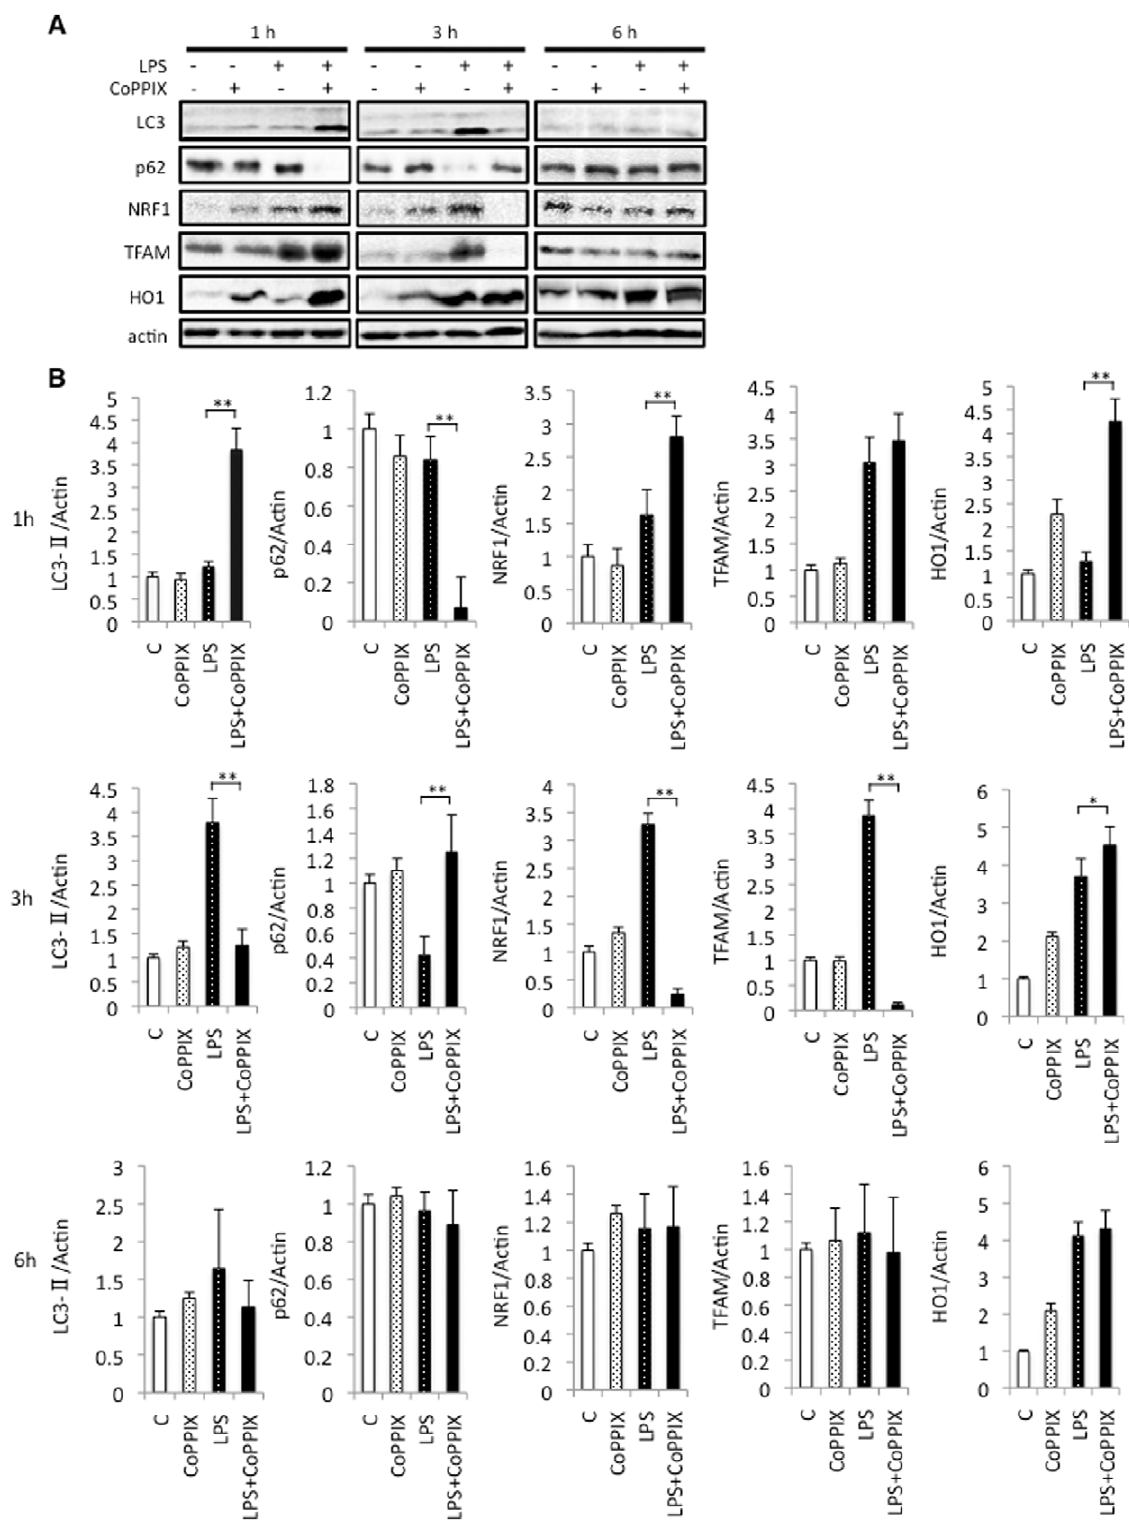
Figure 3. Effects of CoPPIX on autophagy and mitochondrial biogenesis during LPS treatment in the heart. A, Western blot analysis of the rat heart treated with LPS (15 mg/kg for 1, 3, and 6 h) with or without CoPPIX pretreatment (5 mg/kg, 24 h) to determine the levels of LC3-II, p62, NRF1, TFAM, and HO1. Actin was detected as a loading control. B, Ratios between LC3, p62, NRF1, TFAM, HO1, and actin determined using densitometry analysis. Each bar represents the mean 6 S.E. of four animals (** p , 0.01; * p , 0.05). Times indicated at the leftmost in the panel show the treatment times for LPS.